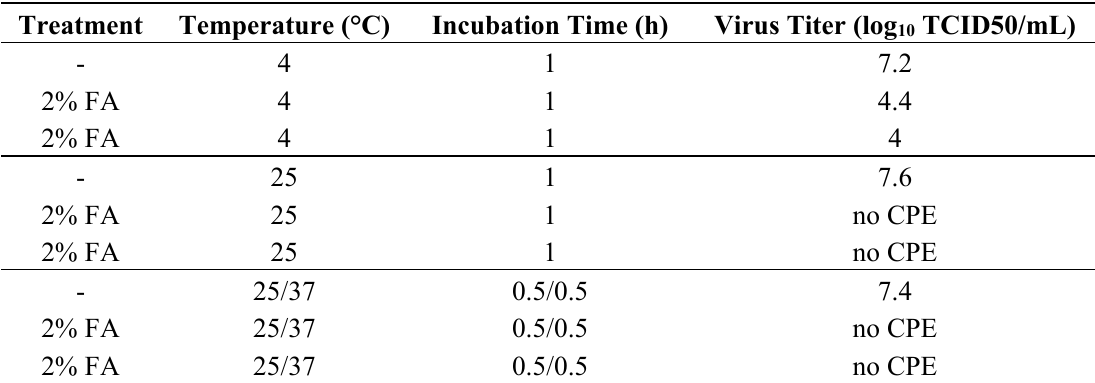
Table 3. Efficiency of Murine norovirus inactivation by formaldehyde at different temperatures. Virus titer was determined by TCID50 assay.